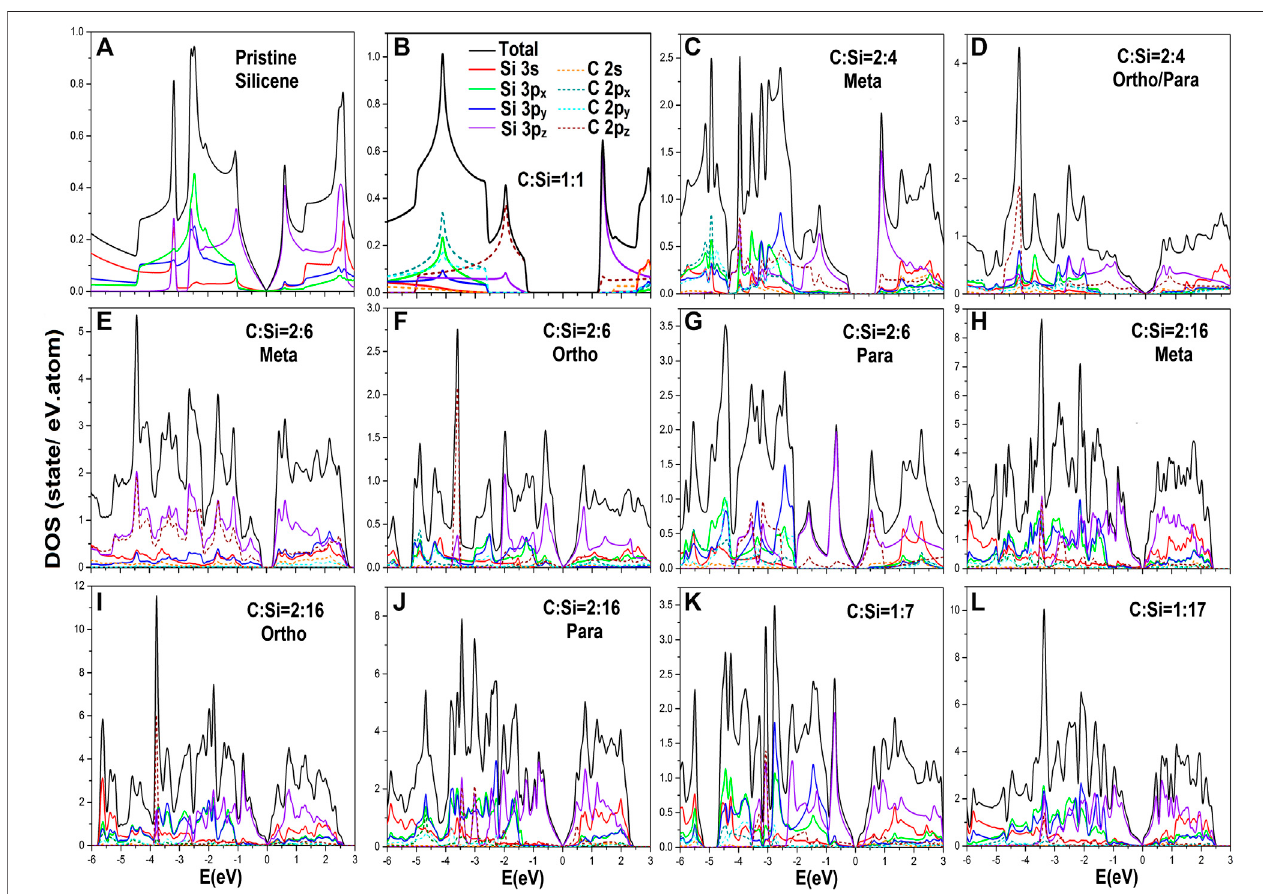
FIGURE5| ThevariousvanHovesingularitiesinatom-andorbital-decomposeddensity-of-statesforcarbon-substitutedsilicenesystemsunderthevariouscases: (A) pristine, (B) [1:1]-, (C) [2:4]-meta-, (D) [2:4]-ortho-/para-, (E) [2:6]-meta-, (F) [2:6]-ortho-, (G) [2:6]-para-, (H) [2:16]-meta-, (I) [2:16]-ortho-, (J) [2:16]-para-, (K) [1:7]- single-, and (L) [1:17]-single-con fi